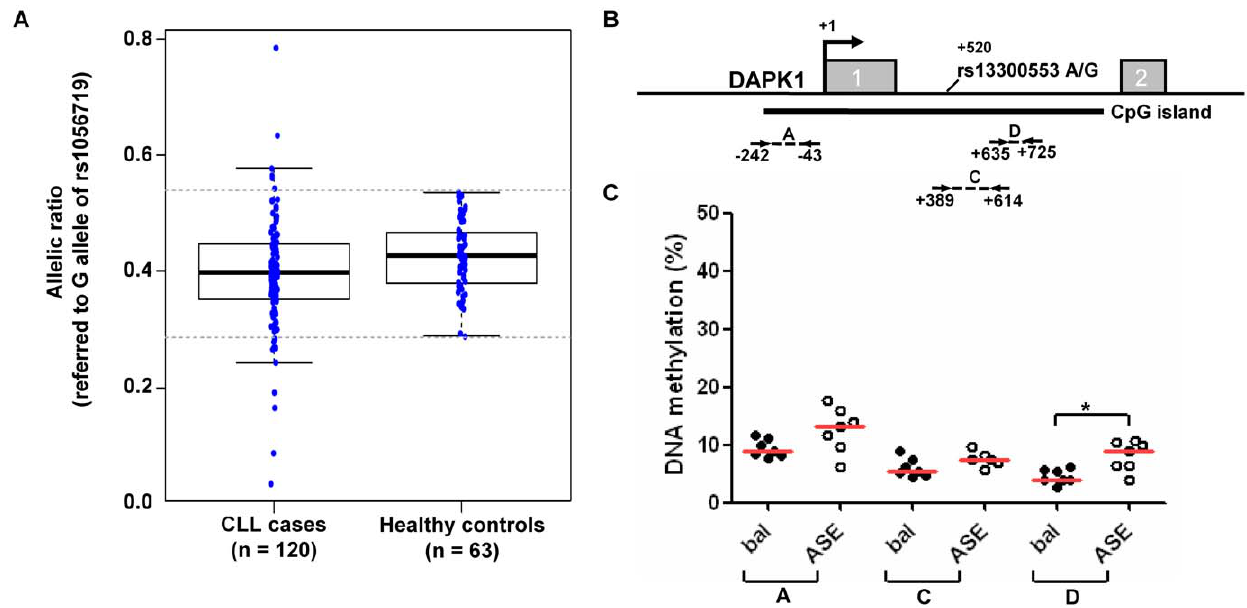
Figure 2. DAPK1 allele-specific expression (ASE) in CLL patients. (A) 120 CLL cases and 63 controls were analyzed for DAPK1 ASE using the informative SNP rs1056719 (G/A) as outlined previously. Allelic ratios (in relation to the G allele) of DAPK1 mRNA from peripheral blood mononuclear cells (PBMCs) were measured with the outlined SNuPE/MALDI-TOF-based method. Dashed lines mark statistically (Youden index outlier method) determined thresholds to identify ASE positive outliers contributing to the significant variability of CLL compared to healthy controls. The centre of these thresholds (0.29 and 0.54, dashed lines) is the estimated average (0.4) of the CLL sample group. (B) Scheme of the DAPK1 promoter region with grey boxes representing the first 2 exons of DAPK1 . Nucleotide positions are given relative to DAPK1 transcriptional start site (TSS). Dashed lines represent positions of the investigated regions/amplicons. (C) Quantitative DNA methylation analysis in the amplicons A, C and D (as described in figure 4) for the seven most imbalanced and seven most balanced CLL patients with regard to DAPK1 mRNA expression. Scatter plots represent mean amplicon methylation levels. Significance was assessed by non-parametric Mann-Whitney-U test (* indicates p , 0.01).